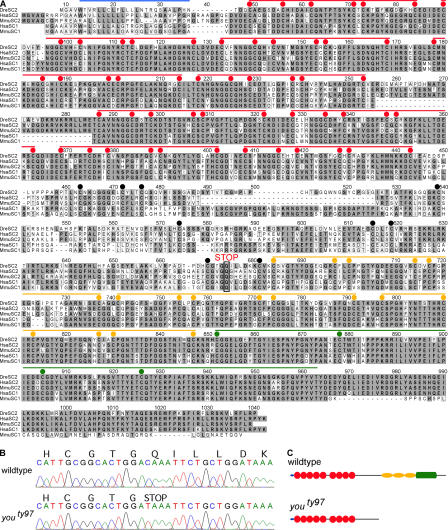
SCUBE Protein Alignment and Truncation of the You ProteinIn (A) and (C), the signal peptide is labeled in blue, the nine EGF domains are labeled in red, and the CUB domain is labeled in green.(A) Alignment of the predicted You amino acid sequence with SCUBE proteins in mouse and human. Identical amino acids are shaded, and similar amino acids are boxed. Conserved cysteines in these domains and elsewhere in the alignment are indicated by filled circles. A conserved six-cysteine repeat motif N-terminal to the CUB domain is labeled in yellow. The location of the glutamine residue at amino acid 644 in the zebrafish protein, which is changed to a stop codon in youty97 mutants, is boxed in bold.(B) Sequence traces from homozygous wild-type and youty97 embryos. In youty97 mutants, a C to T transition is predicted to change a glutamine codon (CAA) to a stop codon (TAA) and truncate the open reading frame.(C) Model of You protein domain structure. The You protein in youty97 mutants is predicted to be truncated prior to the six-cysteine repeat motifs, the CUB domain, and the conserved C-terminus.